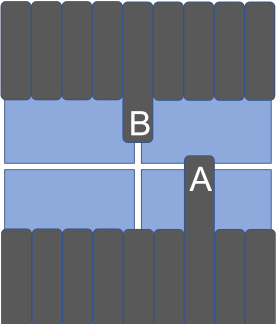
Figure 2. The dead areas lead to leaf position reconstruction issues when the leaves move perpendic- ular to the dead area (case A) and along the dead area (case